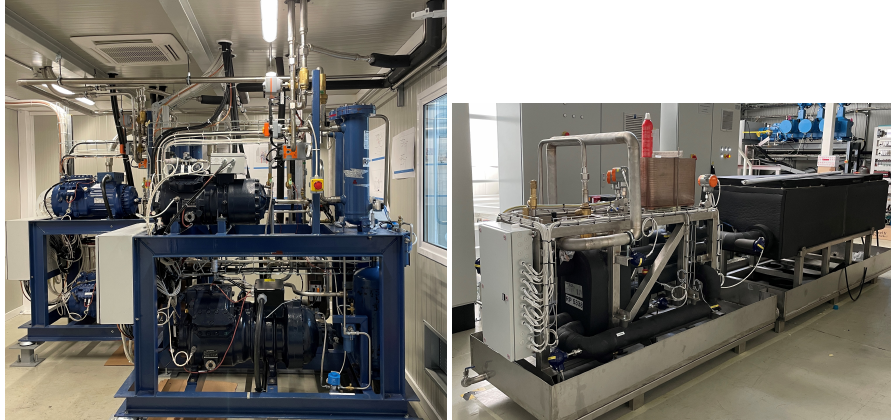
Figure 6. ( left ) Chiller room with two compressor slices and connections to gas coolers and common unit ( right ) Dummy load used to replicate operation of 2PACL system and heat